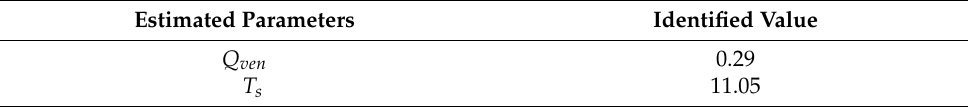
Table 2. Optimised model parameters.